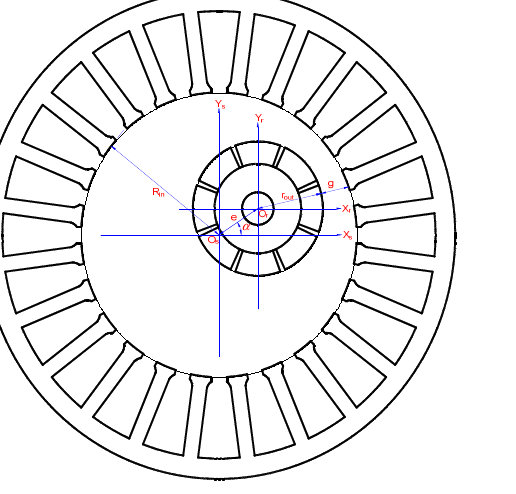
Figure 1. Schematic diagram of air-gap eccentricity.